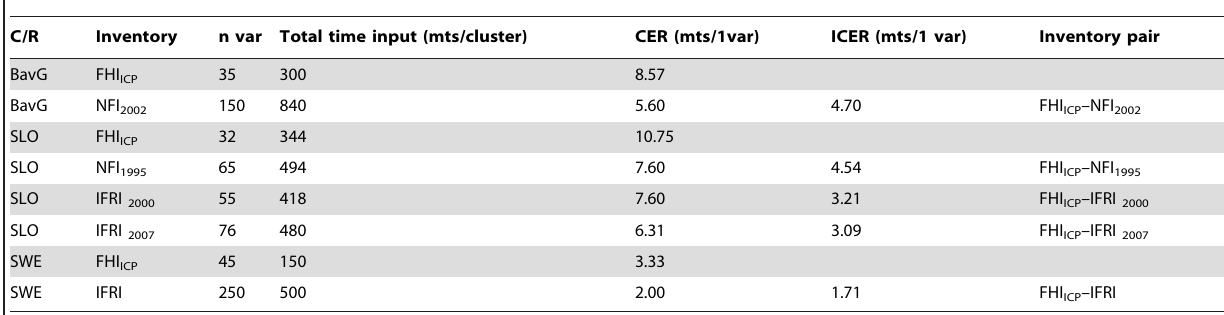
Table 7. Cost-effectiveness of the inventory